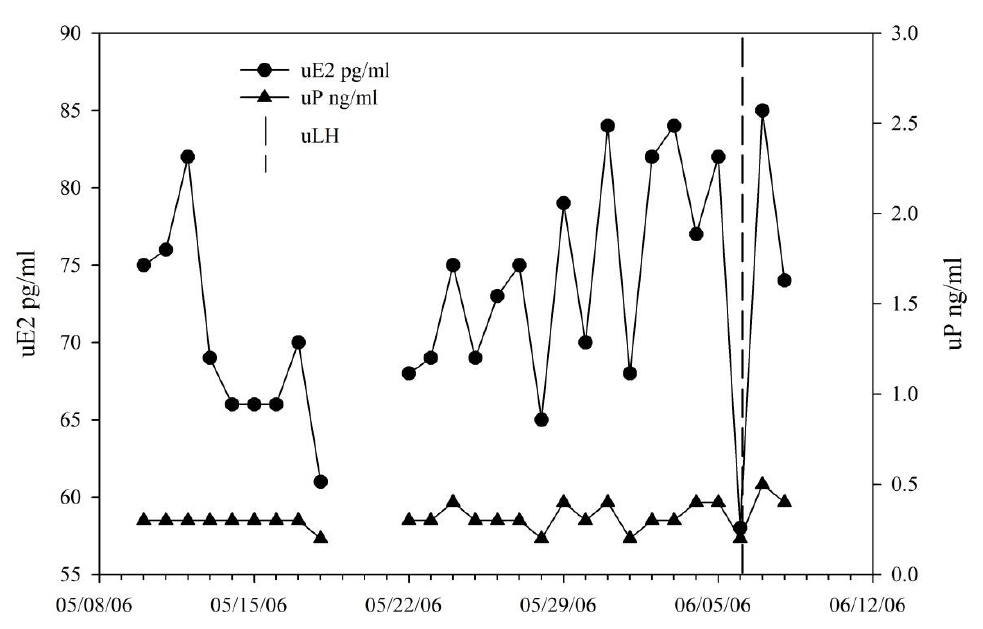
Figure 4. Animal 1 urinary estradiol, progesterone and luteinizing hormone. Reproductive